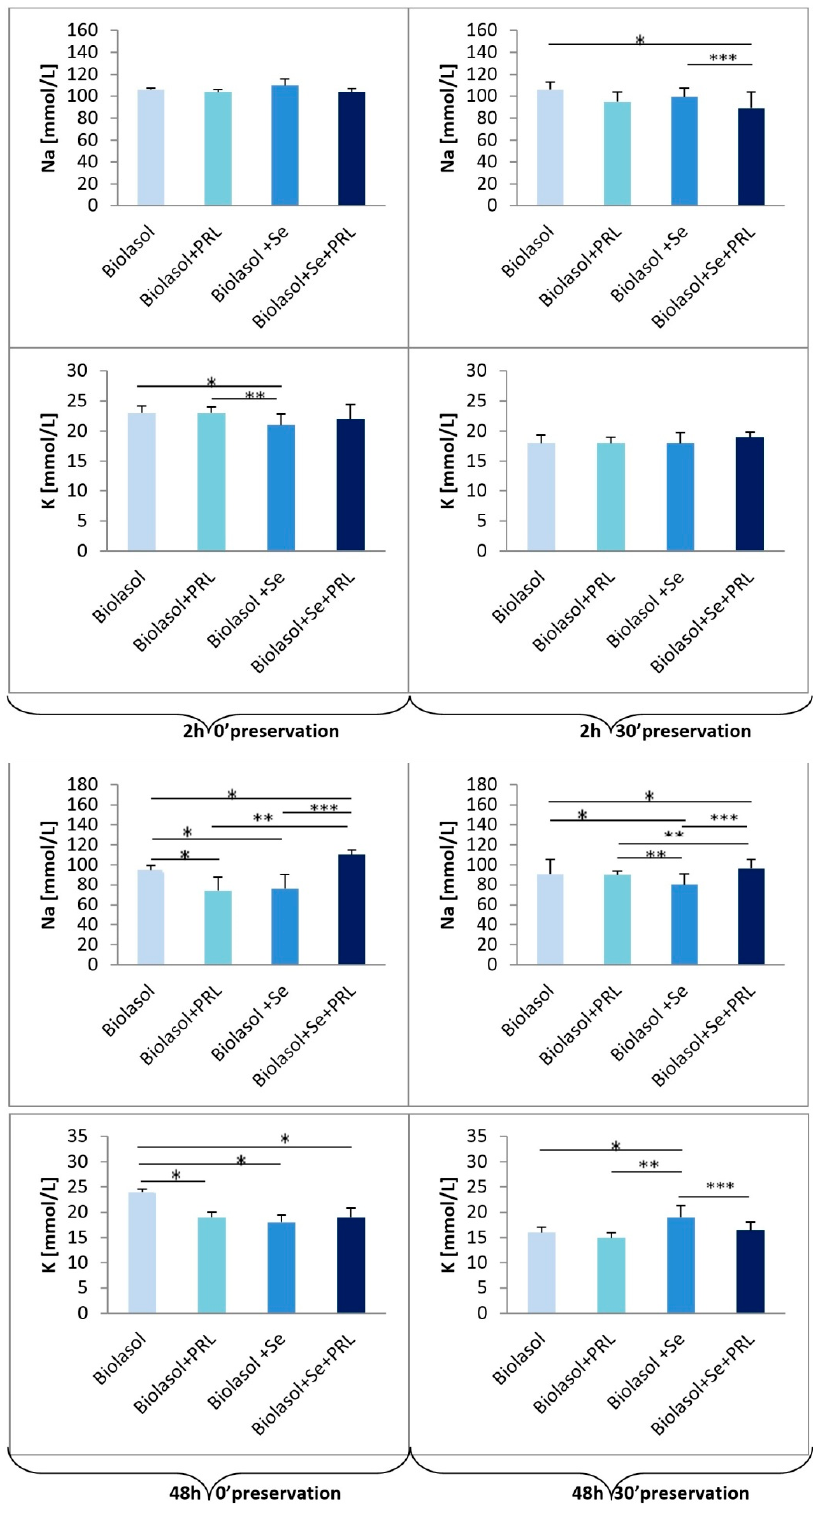
Figure 4. The e ff ect of selenium on sodium and potassium levels in porcine kidneys (2 h 0 (cid:48) ; 2 h 30 (cid:48) and Figure 4. The effect of selenium on sodium and potassium levels in porcine kidneys (2 h 0 ′ ; 2 h 30 ′ 48 h 0 (cid:48) ; 48 h 30 (cid:48) preservation). Means ± standard deviations (SD) are shown. The symbols represent a and 48 h 0 ′ ; 48 h 30 ′ preservation). Means ± standard deviations (SD) are shown. The symbols significant di ff erence ( p < 0.05) compared with the Biolasol ® group (*), the Biolasol ® + PRL group (**), represent a significant difference ( p < 0.05) compared with the Biolasol ® group (*), the Biolasol ® +PRL and the Biolasol ® + Se group group (**), and the Biolasol ® +Se group (***).